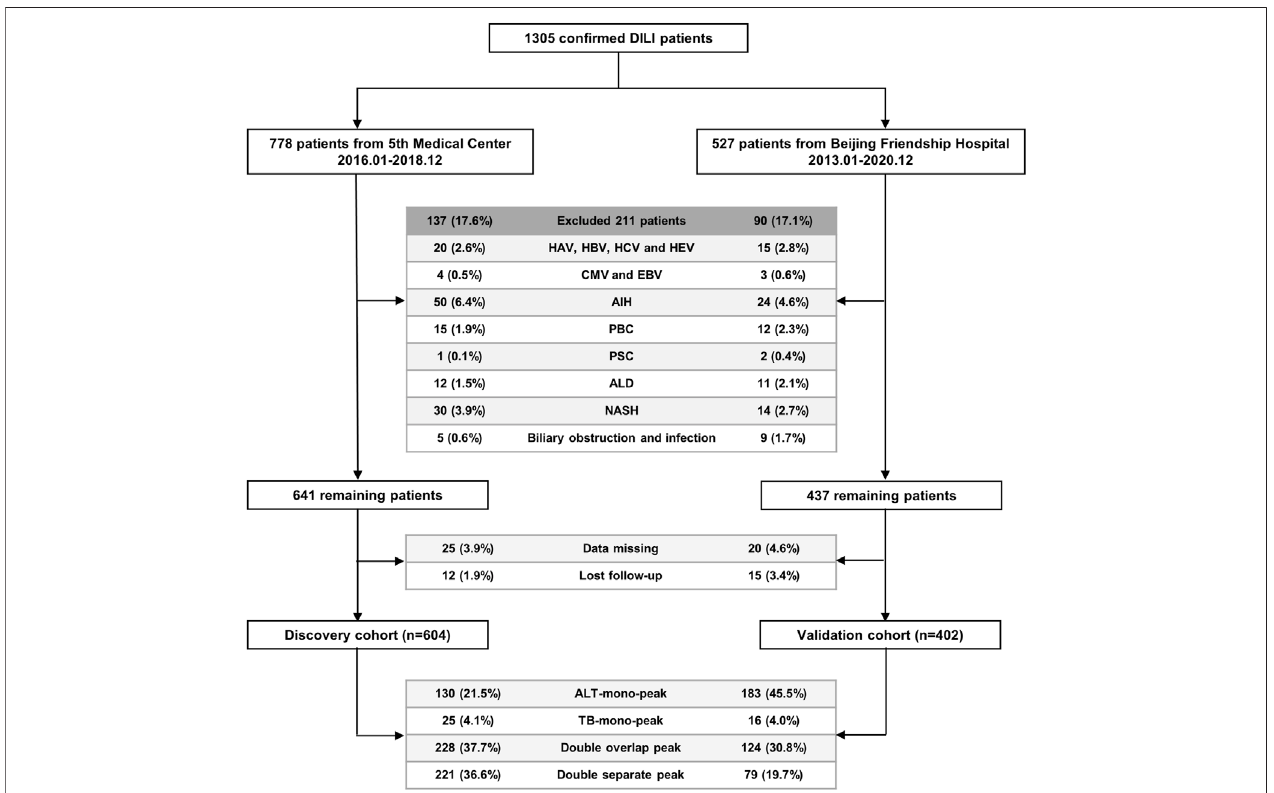
FIGURE2| FlowchartoftheenrolledpatientswithDILIinthediscovery and validation cohorts. Abbreviations:DILI,drug-inducedliverinjury; HAV,hepatitis Avirus; HBV, hepatitis B virus; HCV, hepatitis C virus; HEV, hepatitis E virus; CMV, cytomegalovirus; EBV, Epstein-Barr virus; AIH, autoimmune hepatitis; PBC, primary biliary cholangitis; PSC, primary sclerosing cholangitis; ALD, alcoholic liver disease; NASH, non-alcoholic steatohepatitis; ALT, alanine aminotransferase; TB, Total bilirubin.